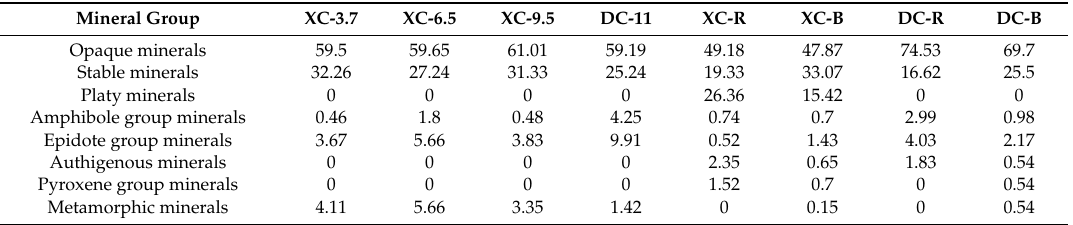
Table 4. Percentages (%) of heavy mineral groups of sediment samples at Xichong and Dongchong. Mineral Group XC-3.7 Opaque minerals